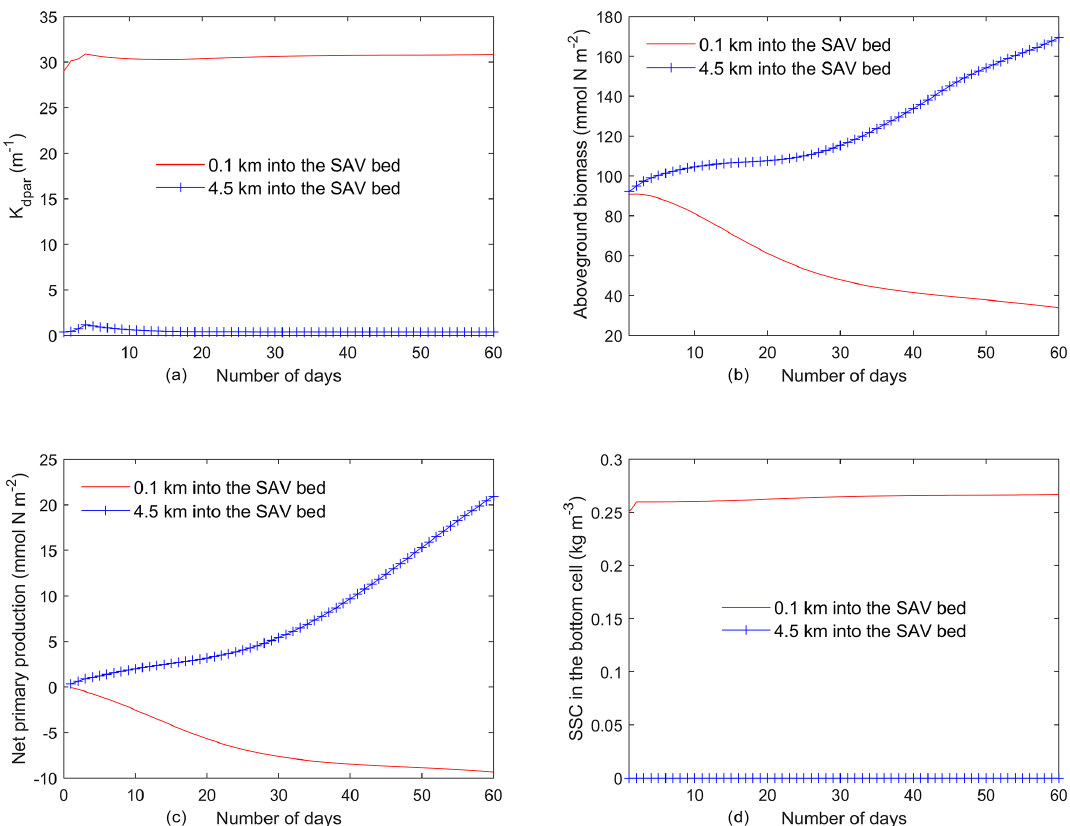
Figure 6. Time series of (a) light attenuation, (b) aboveground biomass, (c) net primary production of SAV ( ρ s − δ s − ε s ), and (d) SSC in the bottom cell averaged every day from the two locations identified in Fig. 5a.